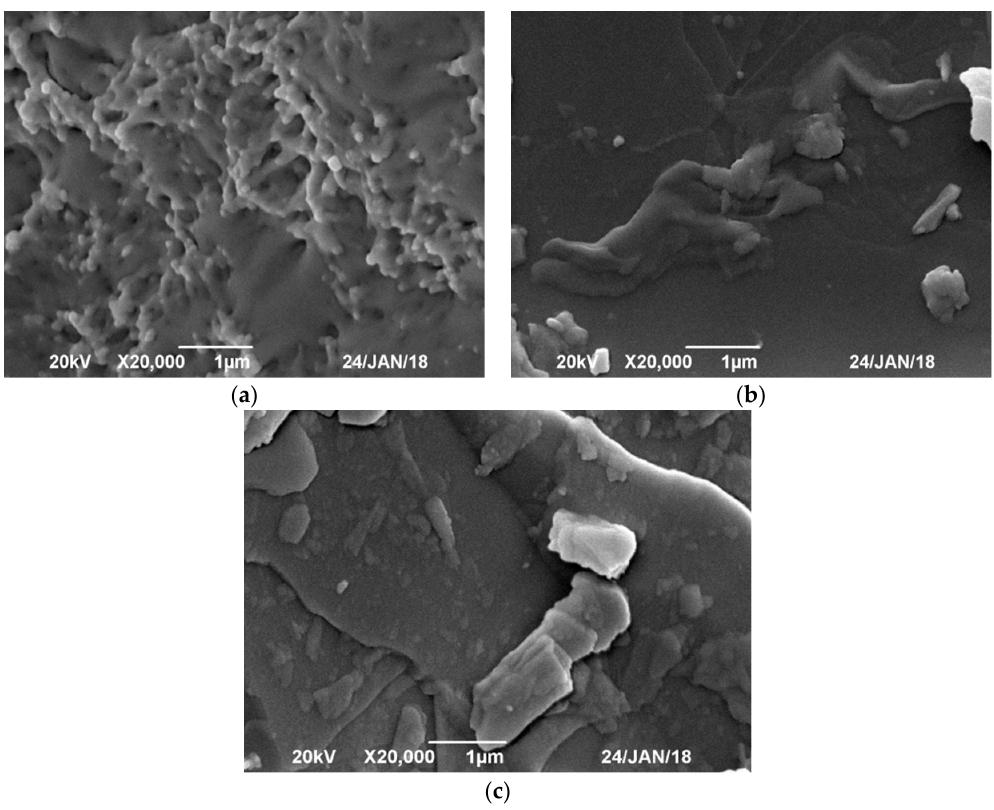
Figure 9. Scanning electron micrographs (secondary electrons), showing FPY adhered onto the surface of ( a ) − 74 + 38 μ m, ( b ) − 38 μ m, and ( c ) − 10 μ m talc particles conditioned with 60 mg/L FPY at pH 6.5.